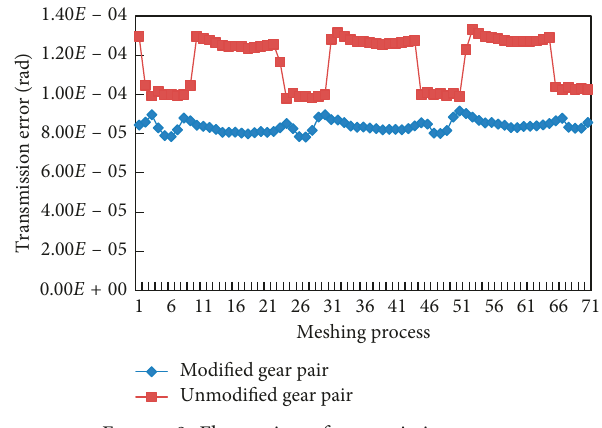
Figure 9: Fluctuation of transmission